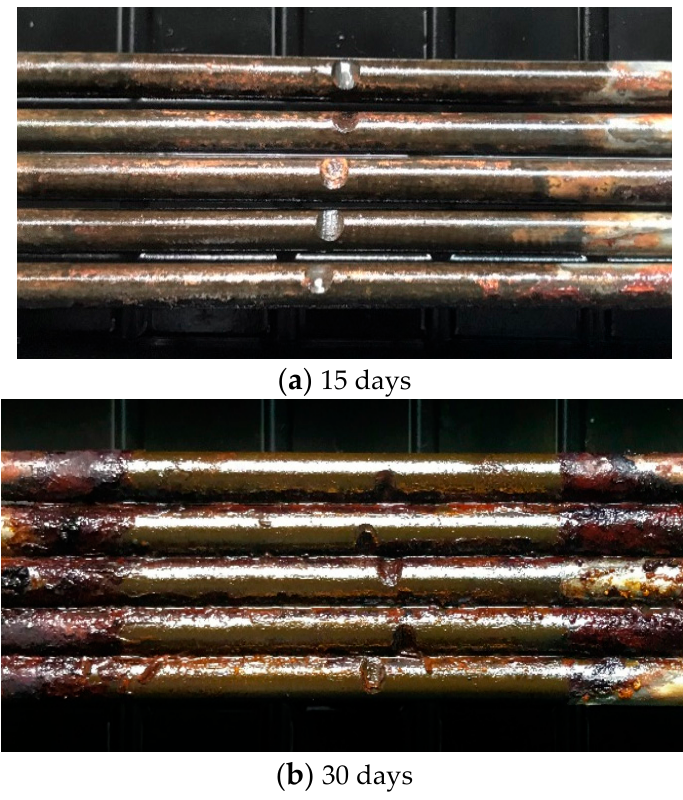
Figure 13. Morphology of steel wire corroded in different times.